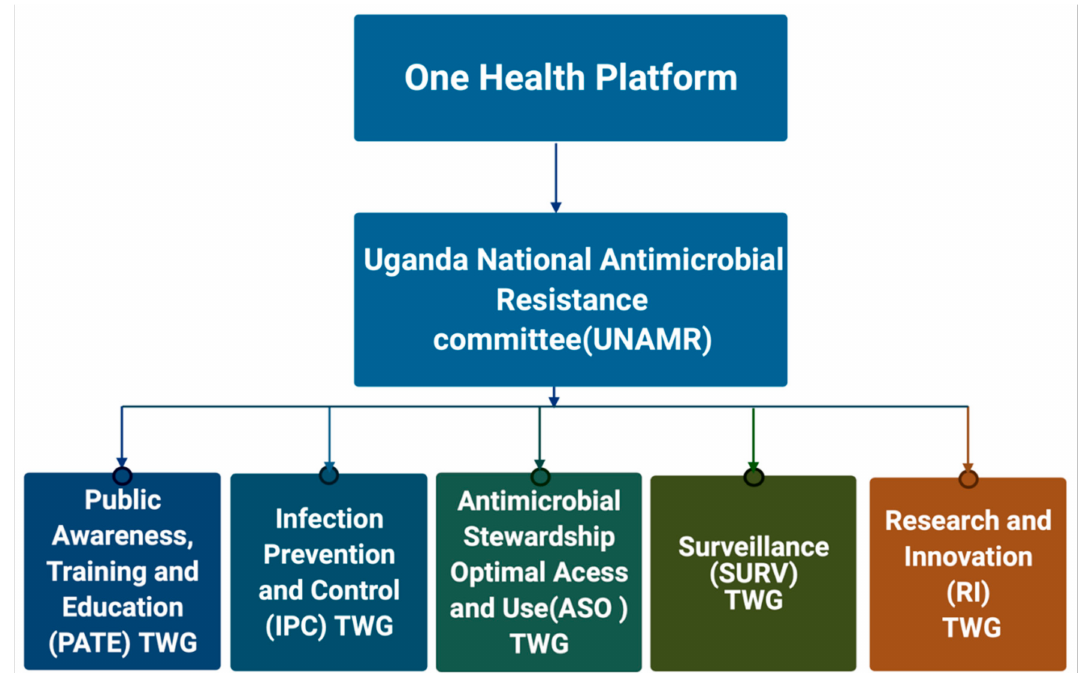
Figure 1. The design of Uganda’s AMR governance structure at national level. On top is the One health platform, under which is the committee that oversees activities on AMR in Uganda. The oversee the pillars on which the National action plan is implemented